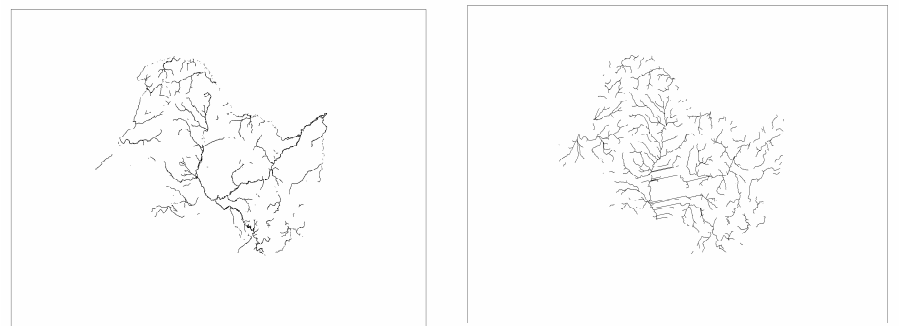
Figure 5. In the SRB, river in land use and the river under the optimal threshold. On the left are the rivers obtained from the land use data. On the right is the river network extracted with the threshold 133,280.